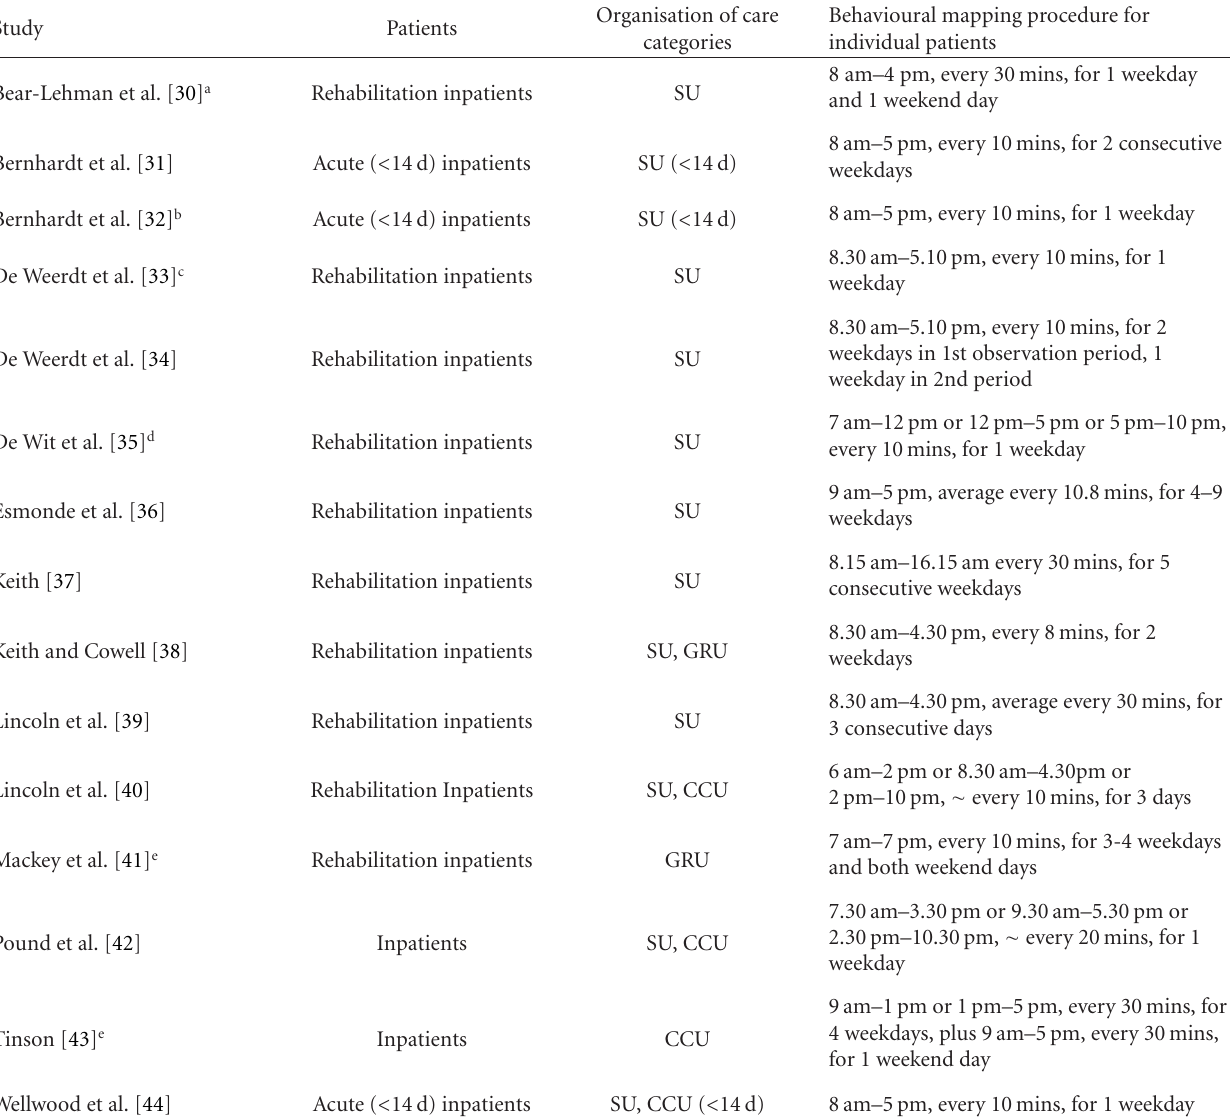
Table 1: General patient activity